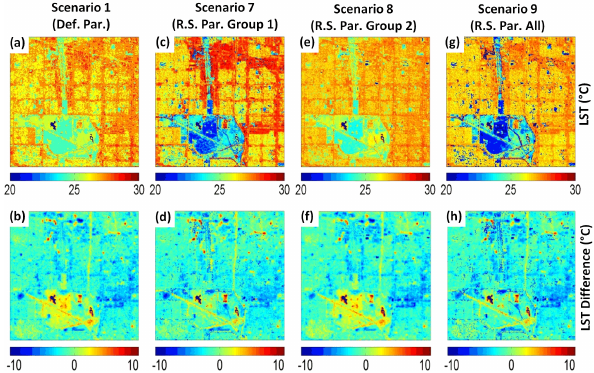
Figure 6. Noah-UCM-simulated LST maps using different urban surface parameterizations: scenarios 1, 7, 8, and 9 from Table 1 (top row) as well as differences between simulated and observed land surface temperature at 1100LST on 14 April 2011 (bottom row).